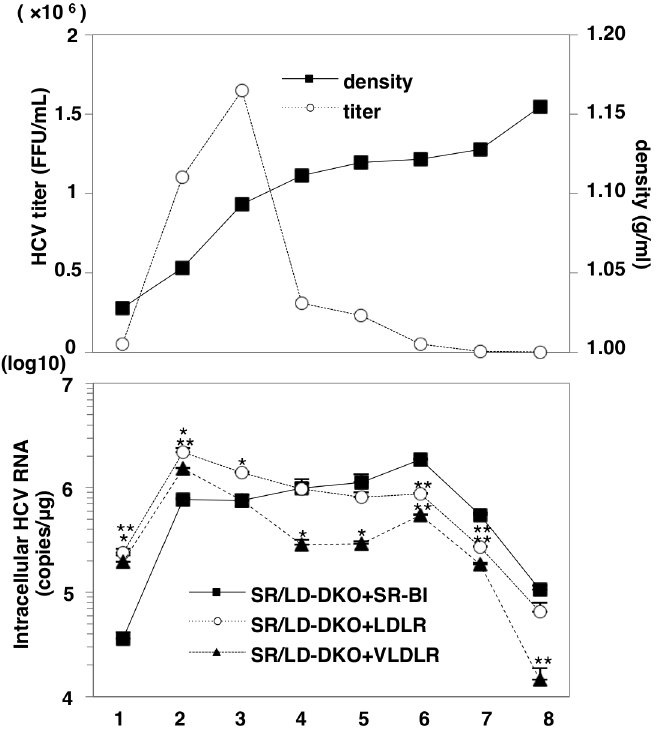
Fig 7. Density-dependent entry of LVPs via lipoprotein receptors. HCV particles in the culture supernatants of Huh7.5.1 cells were harvested at 72 h post-infection with HCVcc and fractionated by using density gradient centrifugation. Infectious titers of each fraction were determined by focus-forming assay and the buoyant density was plotted for each fraction (upper panels). SR/LD-DKO Huh7 cells expressing either SR-B1, LDLR or VLDLR were infected with each fraction and intracellular HCV RNA levels at 24 h post- infection were determined by qRT-PCR (lower panel). Asterisks indicate significant differences ( * P < 0.05; ** P < 0.01) versus the results for SR/LD-DKO Huh7 cells expressing